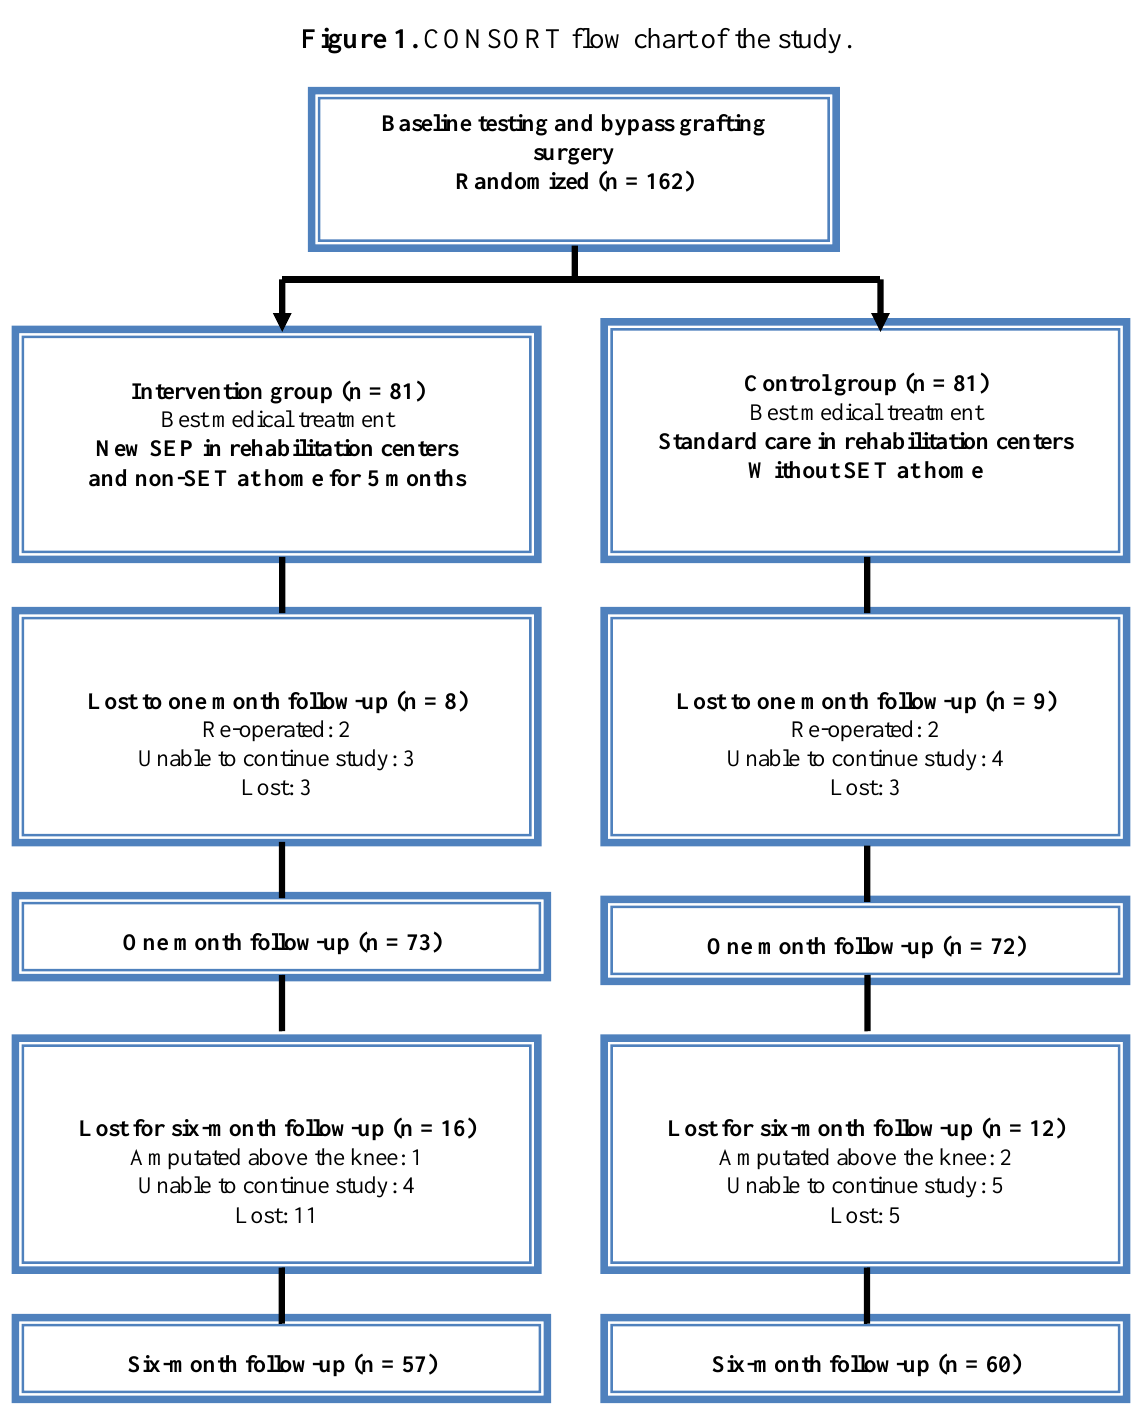
Figure 1. CONSORT flow chart of the